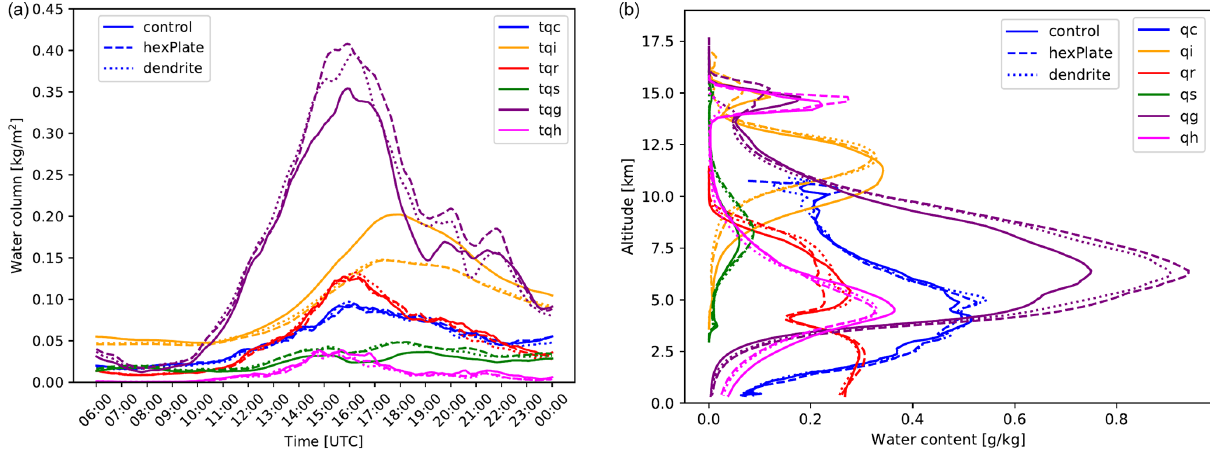
Figure 10. Temporal evolution of the atmospheric liquid and ice water paths on 5 July 2015 (a) and in-cloud water content profiles at 16:00UTC (b) with three (control, hexPlate, dendrite) cloud ice